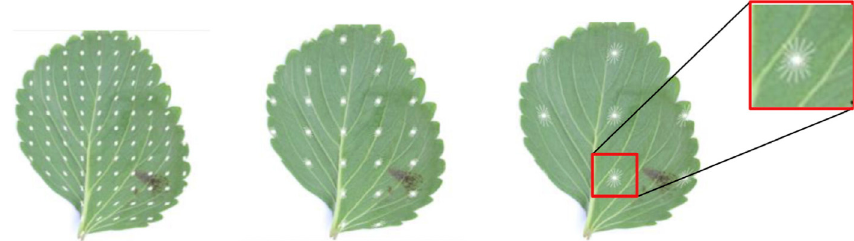
Figure 4. Strawberry leaf with different cell sizes Histogram of Gradients (HOG) was applied (white arrows indicate the obtained gradient information; RGB patches directions and arrow lengths represent the size of the gradients) [75].